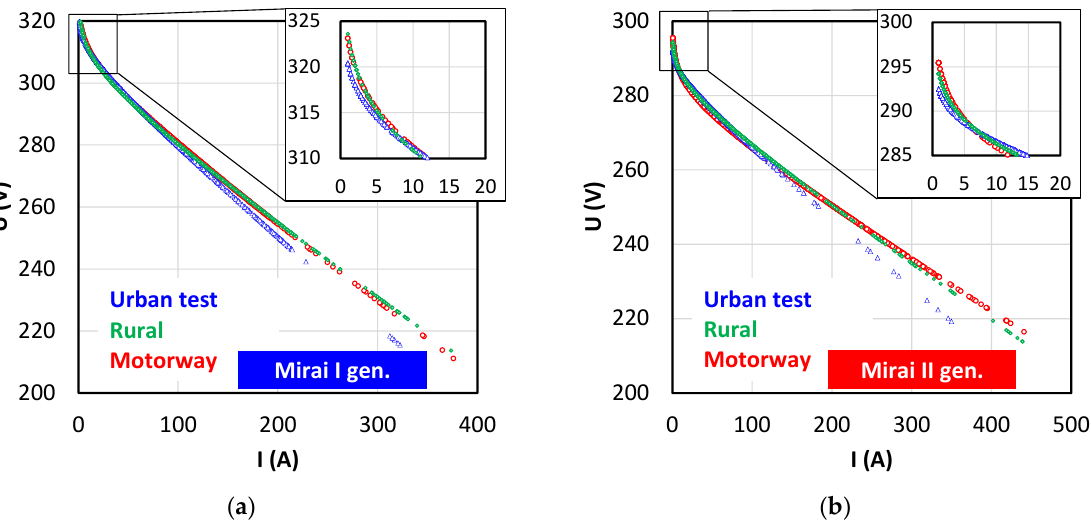
Figure 18. Comparison of model characteristics of the fuel cell stack for each phase of the road test: ( a ) I generation FCHEV drive; ( b ) II generation FCHEV drive.